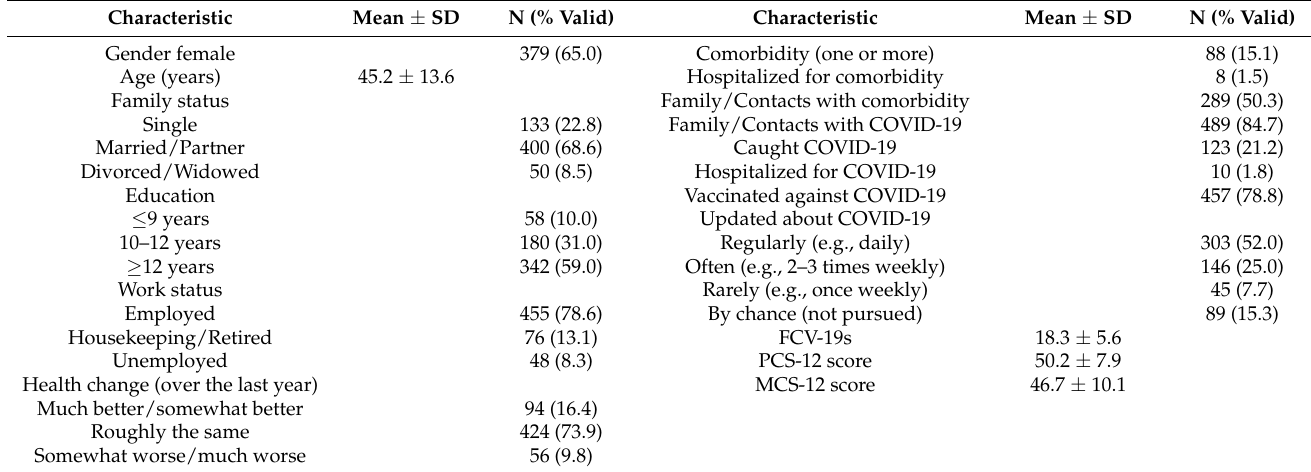
Table 1. Characteristics of the sample (N = 583).